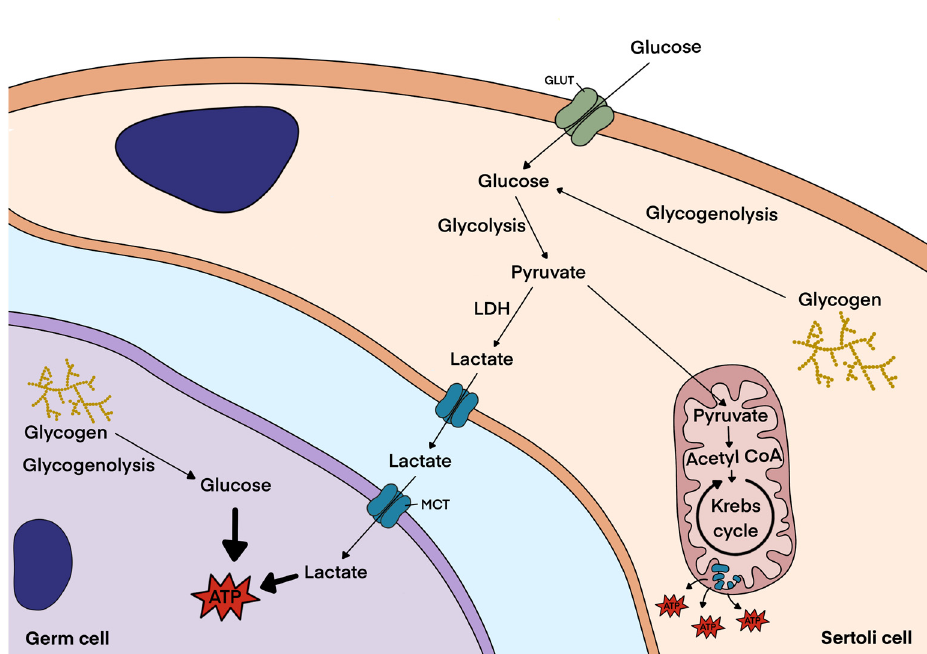
Figure 4. Illustration of the role of glycogen on Sertoli cell and germ cell metabolism. In Sertoli cells, glycogenolysis results in the release of glucose which undergoes glycolysis to produce lactate, the preferential energy source of germ cells. Lactate is transported from Sertoli cells to germ cells by monocarboxylate transporters (MCTs). Pyruvate, resultant from glycolysis, can also be used for energy production through oxidative phosphorylation in the mitochondria. Abbreviations: GLU—glucose transporter, LDH—lactate dehydrogenase, MCT—monocarboxylate transporter.